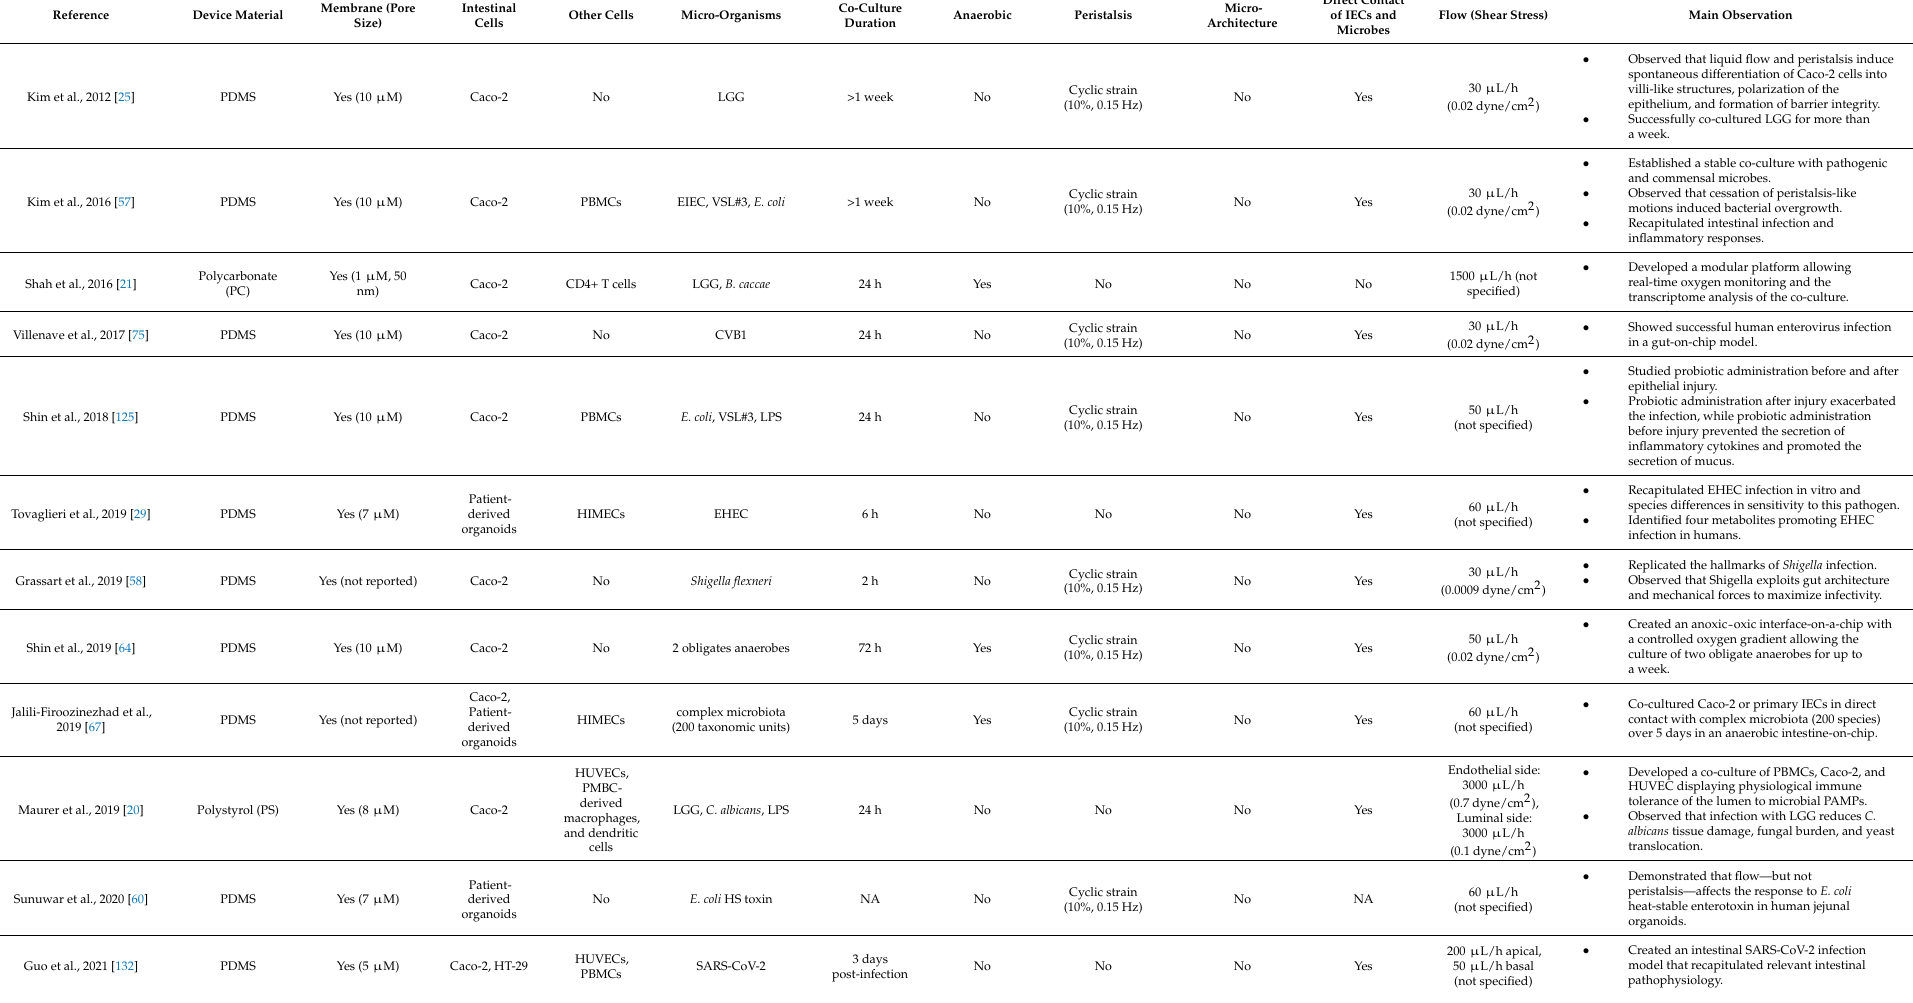
Table 1. Gut-on-chip models to study host – microbial interactions reported in the